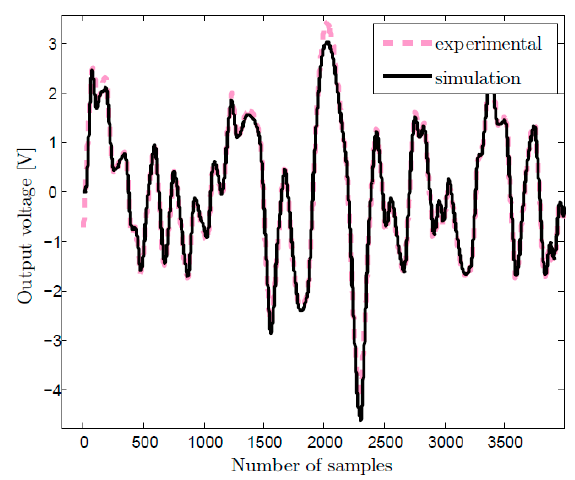
Figure 14. Simulation results and experimental data comparison.